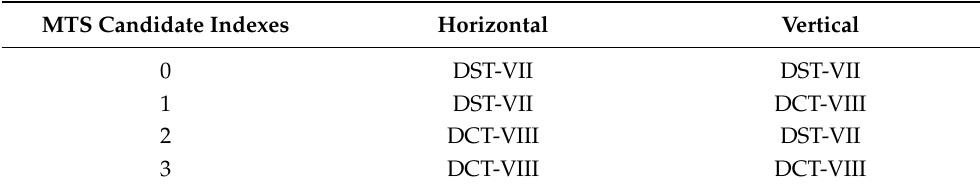
Table 1. The mapping relationship between MTS indexes and